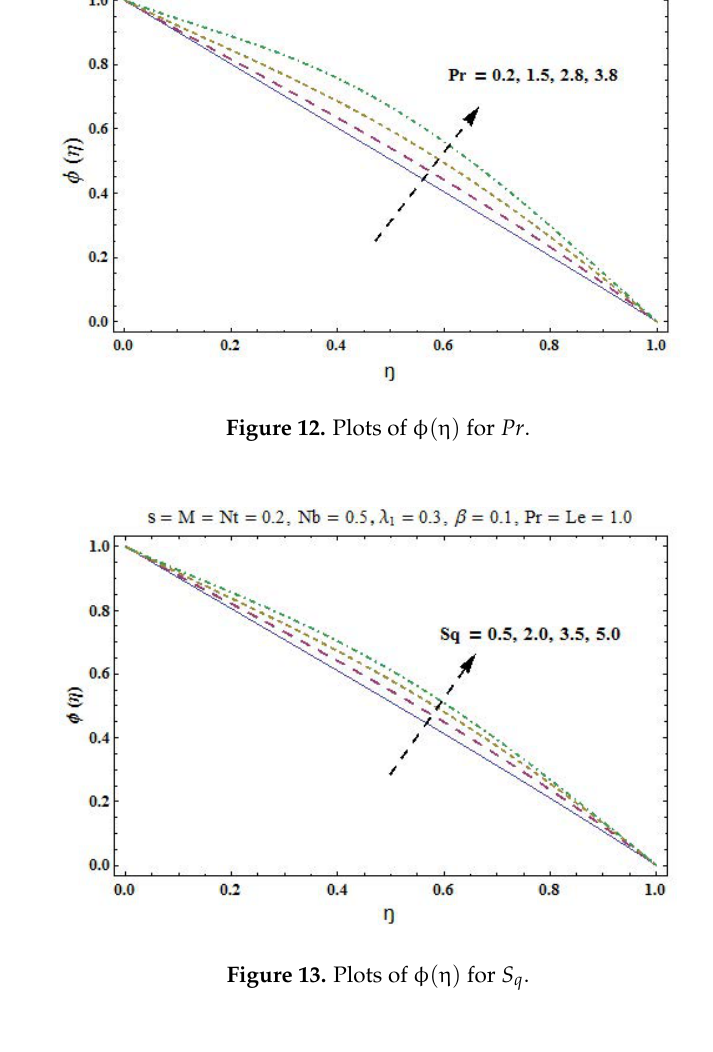
Table 3. Comparative values of f (cid:48)(cid:48) ( 1 ) for different values of M when Sq = 1.0, S = 2.0 and = β = λ 1